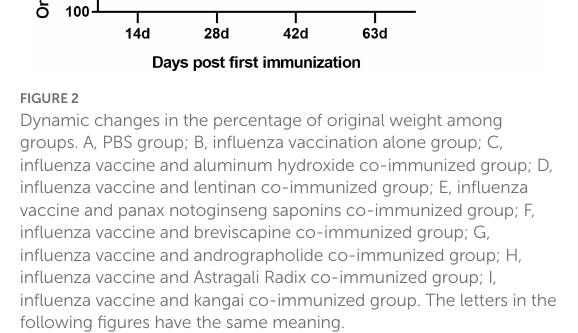
Figure 2. The body weight of the mice increased over time, and there were no significant differences among the groups, which was consistent with the normal growth characteristics of the mice and also indicated that the TCM adjuvant had no side effects on the mice, and no damage to the organs of the mice was observed during sampling.